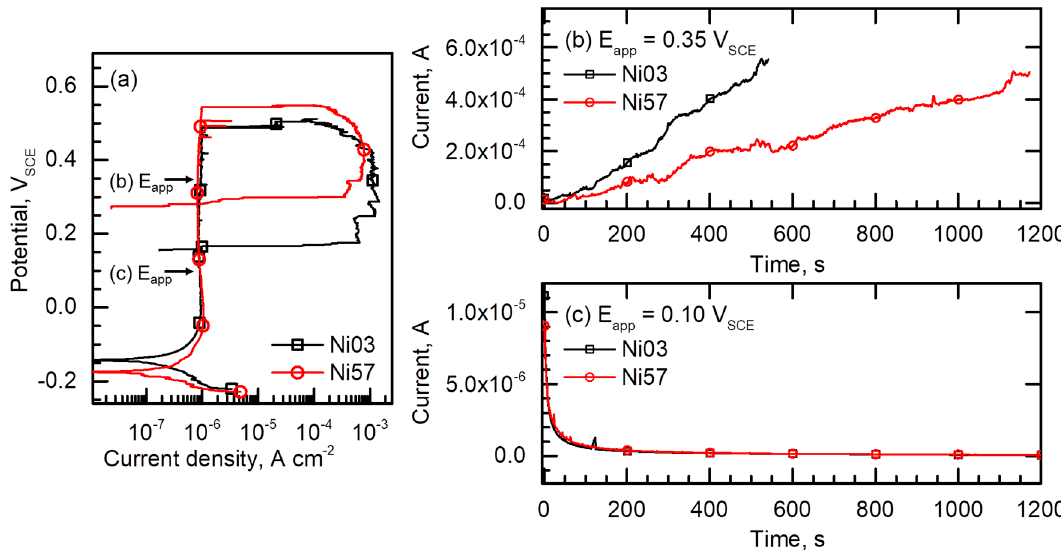
Figure 6. ( a ) Representative cyclic potentiodynamic polarization curves of the Ni03 and Ni57 alloys chosen from Figure 5a,b. Current–time curves of the Ni03 and Ni57 alloys obtained from potentiostatic tests measured in a 2 M NaCl solution at 40 °C under constant applied potentials (E app ) of ( b ) 0.35 V SCE and ( c ) 0.10 V SCE .